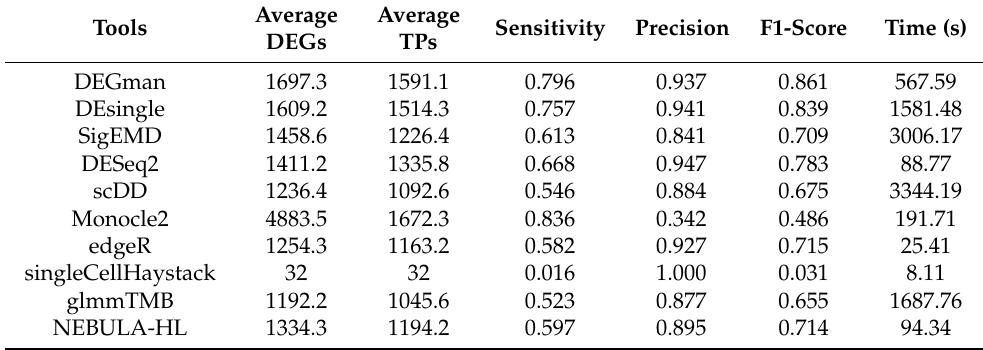
Table 1. Performance comparison of ten tools on the simulated data. Adjusted p -value < 0.05.